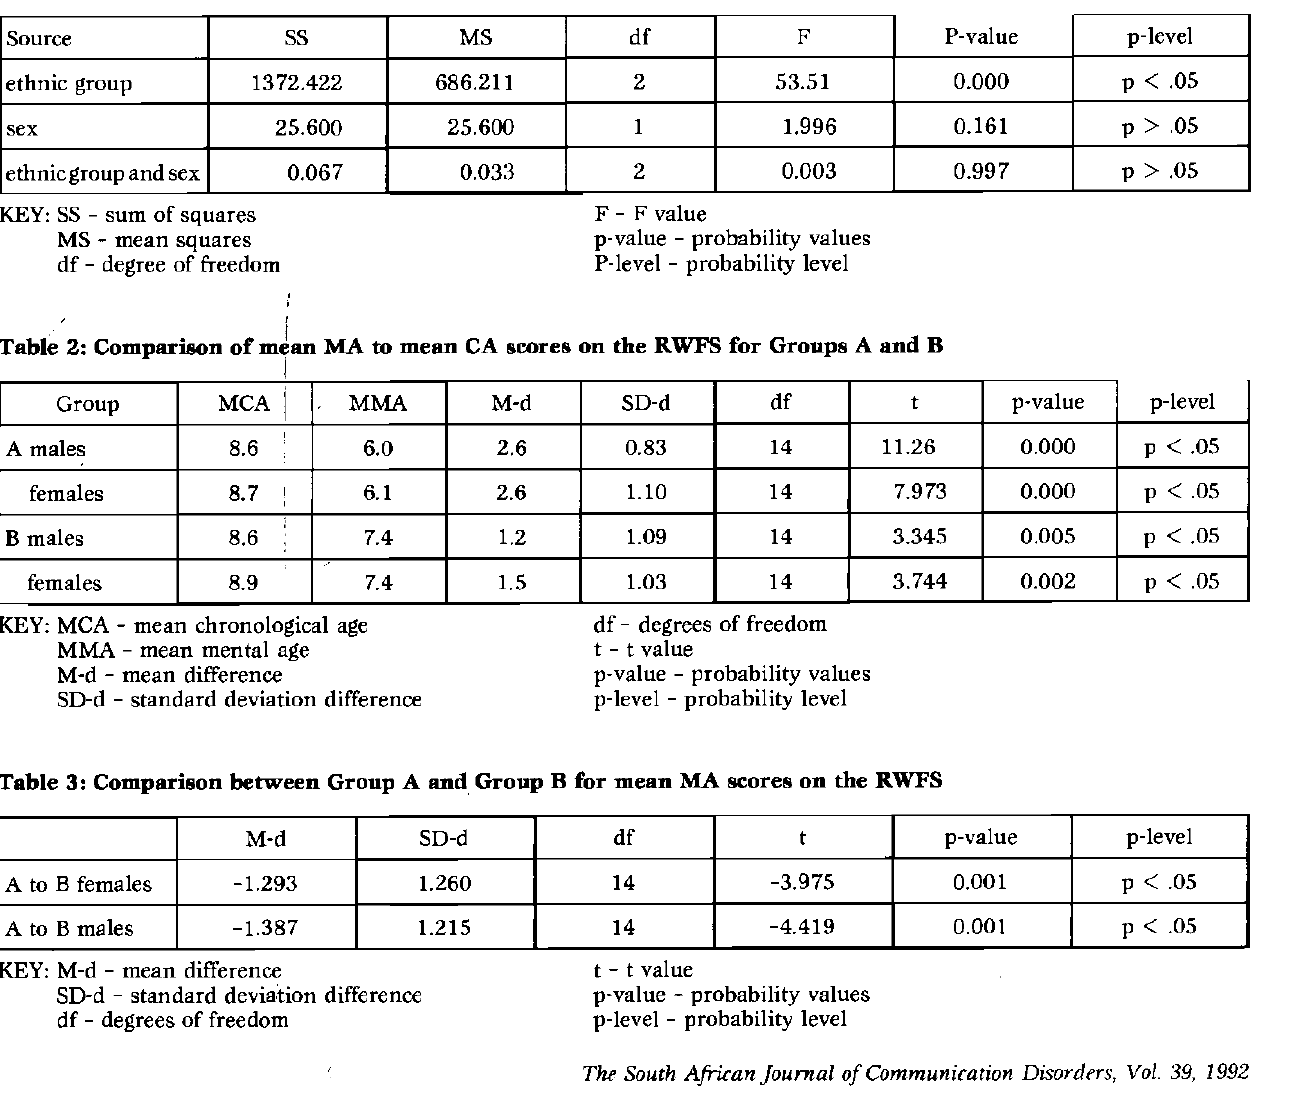
KEY: SS - sum of squares MS - mean squares df - degree of freedom